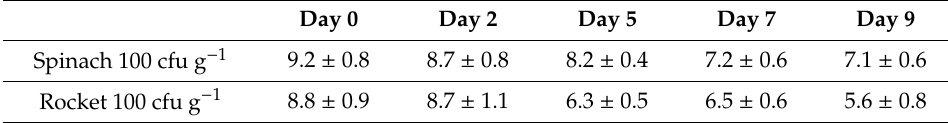
Table 3. Visual (sensory) analysis of spinach and rocket leaves based on product appearance (i.e., gloss, freshness, and colour uniformity and intensity); average results ± standard deviations. 0 refers to ready-to-eat food products being in poor condition to 10 pristine / excellent condition, with 6 being the lowest acceptable commercial score. ‡ indicates product’s sensory quality is unacceptable at that data